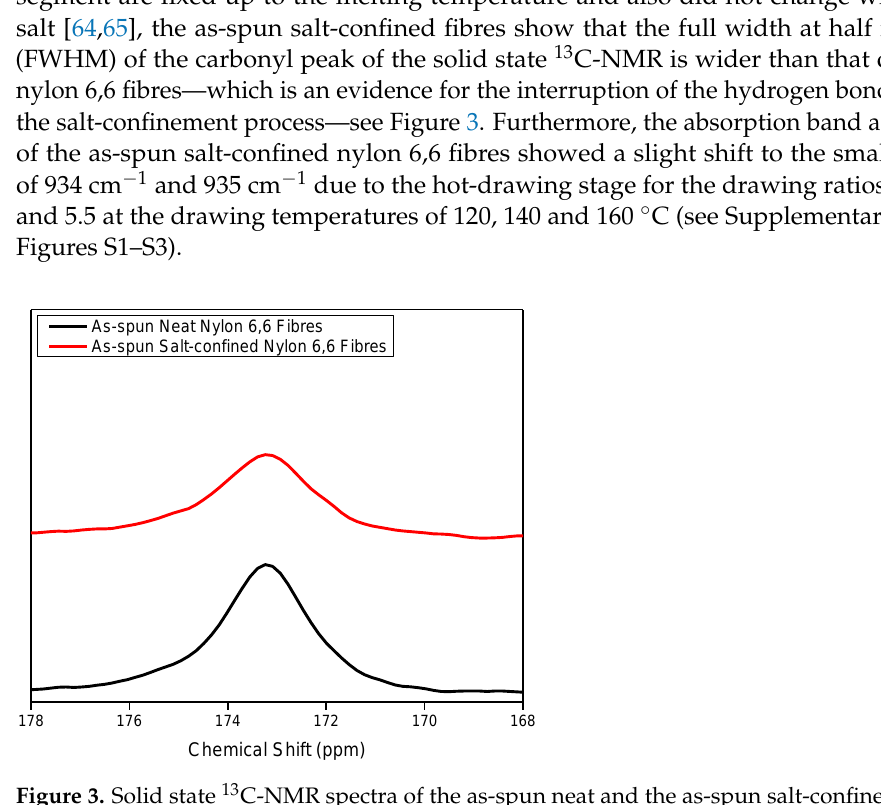
Figure 3. Solid state 13 C-NMR spectra of the as-spun neat and the as-spun salt-confined nylon 6,6 fibres.